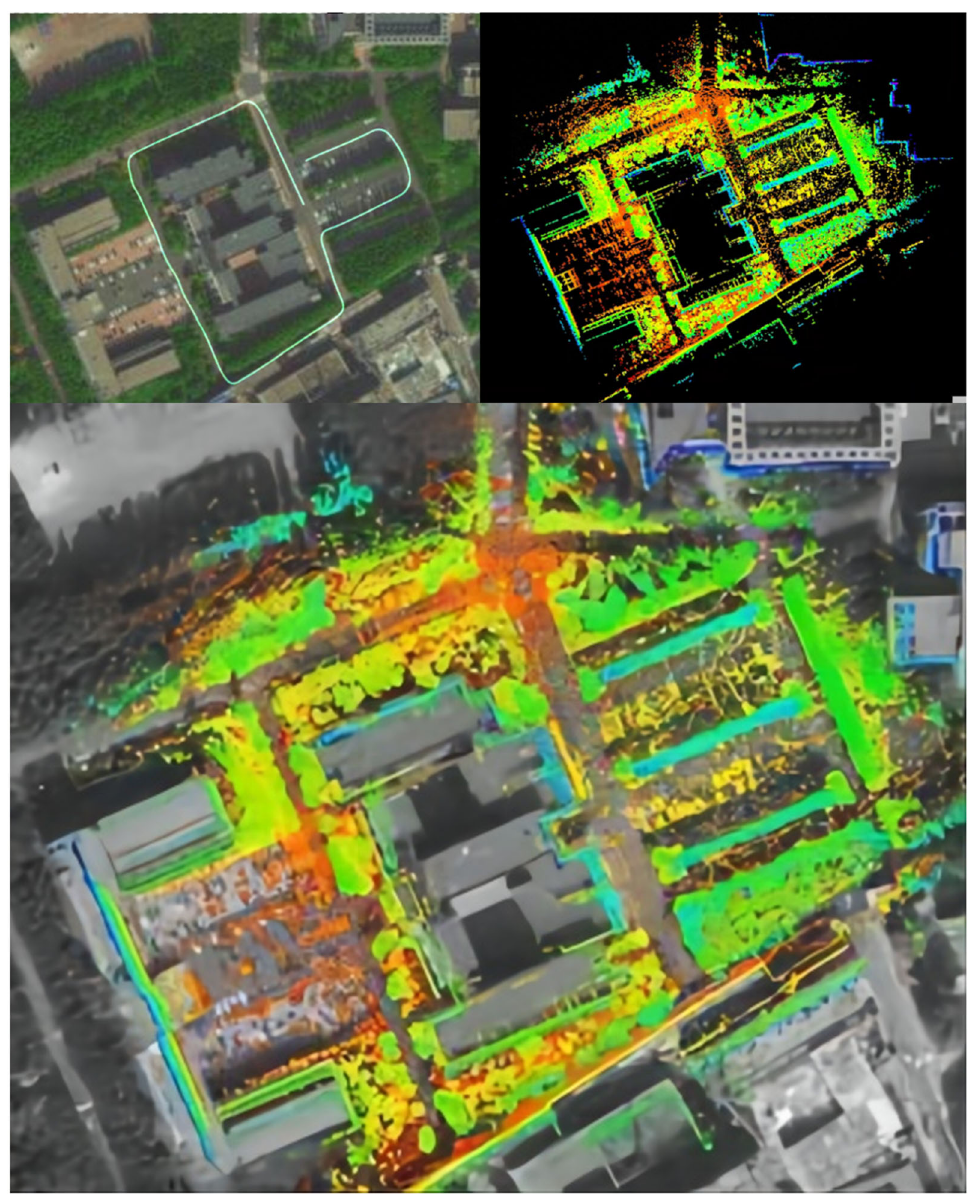
Figure 16. BEV image of the JLU_062801 sequence, LoNiC mapping results, and the superimposed renderings of the BEV image and the point cloud image (the colored trajectory in the BEV image refers to the actual trajectory of the Volkswagen Tiguan).